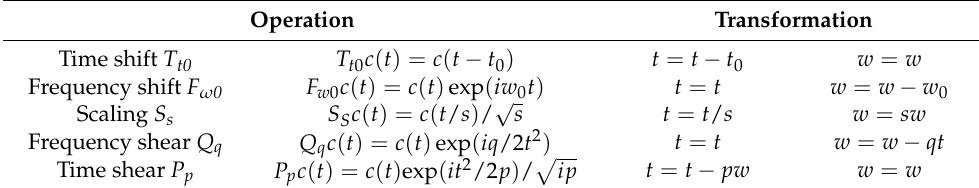
Table 1. Operations for the chirplet transform operators. Operation Transformation